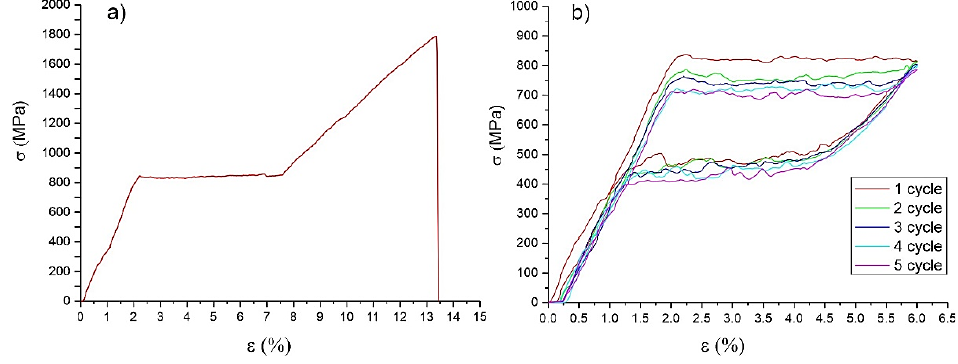
Figure 3. Deformation behavior of TiNi wire: ( a ) tensile test to rupture, ( b ) cyclic test. Cyclic loading – unloading tests were performed within the deformation range that